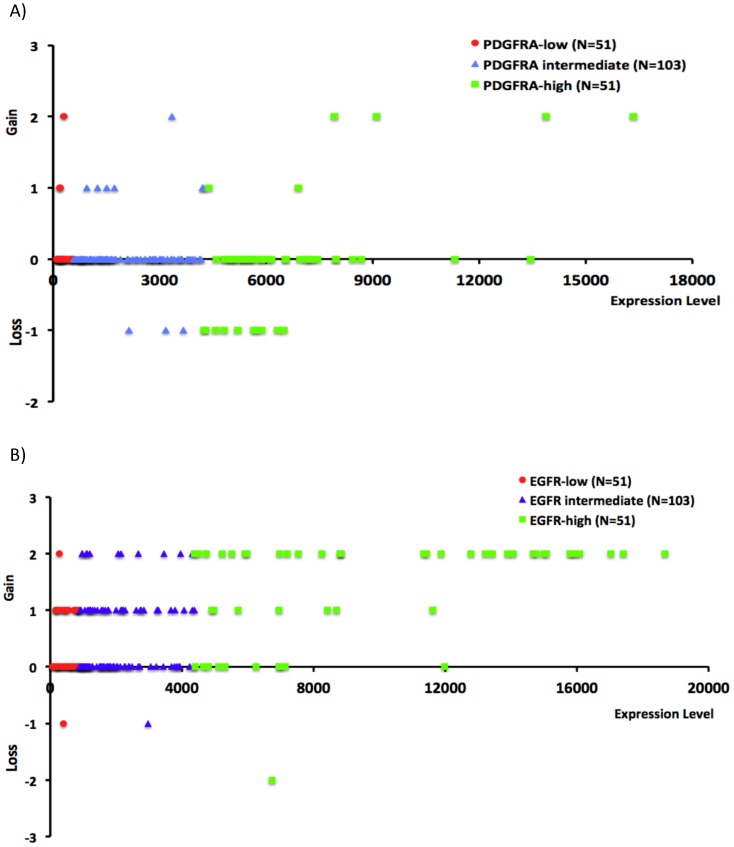
Infrequent association between enriched PDGFRA expression and PDGFRA amplification in glioma genomes.The SNP data in the Rembrandt data set were analyzed for the gain or loss of PDGFRA (A) and EGFR (B) using dChip and GISTIC2.0 with glioma samples grouped according to the relative levels of PDGFRA or EGFR expression. In each plot, the X-axis indicates the relative levels of PDGFRA or EGFR expression, and the Y-axis indicates the extent of PDGFRA or EGFR gain or loss (2, 1, 0, −1 and −2 for above 3.7 copies of genes, 2.3–3.7 copies of gene, no detectable alteration, heterozygous loss, and homozygous loss, respectively).